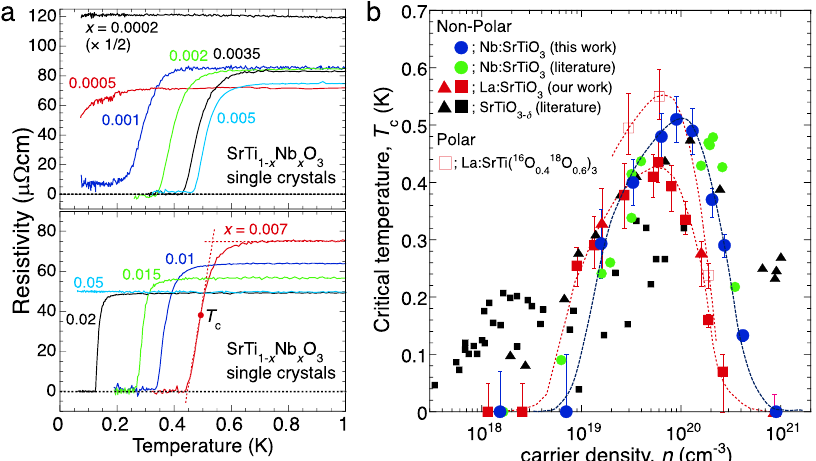
Fig. 2 Superconducting domes of SrTiO 3 − δ , La:SrTiO 3 , and Nb:SrTiO 3 . a Resistivity of our SrTi 1 − x Nb x O 3 single crystals (same samples studied in Fig. 1a) below 1 K for 0.0002 ≤ x ≤ 0.005 (upper panel) and 0.007 ≤ x ≤ 0.05 (lower panel). We de fi ned T c as the mid-point of the resistance drop, as indicated by the three dotted lines for the x = 0.007 data. The intersections of the lines give the onset and end of T c , corresponding to the error bars shown in b The x = 0.0005 sample shows an indication of superconductivity below approximately 0.2 K, but zero resistivity was not achieved at the lowest measured temperature. The T c value increases with increasing x up to x = 0.005 and decreases for x ≥ 0.007. b Superconducting domes of Nb:SrTiO 3 obtained in this work (closed blue circles). The carrier density n is the value at 5 K. The domes of our other works for La:SrTiO 3 (closed red squares 4 and triangles 42 , with the three unpublished data points shown in Supplementary Fig. 1) and La:SrTi( 16 O 0.418 O 0.6 ) 3 (open red squares 4 ) are also plotted. The dashed lines serve as a guide for the eyes. For comparison, other data from the literature are included for Nb:SrTiO 3 (closed green circles 23 ), and SrTiO 3 − δ (closed black triangles 49 and squares 12 carrier density distribution occurs in the SrTiO 3 − δ sample. Hall measurements give the averaged carrier density of the bulk, whereas the observed value of T c is the highest T c among all the percolation paths in the doped regions where the carrier density differs from the average value. When compared with La:SrTiO 3 and SrTiO 3 − δ , Nb:SrTiO 3 shows